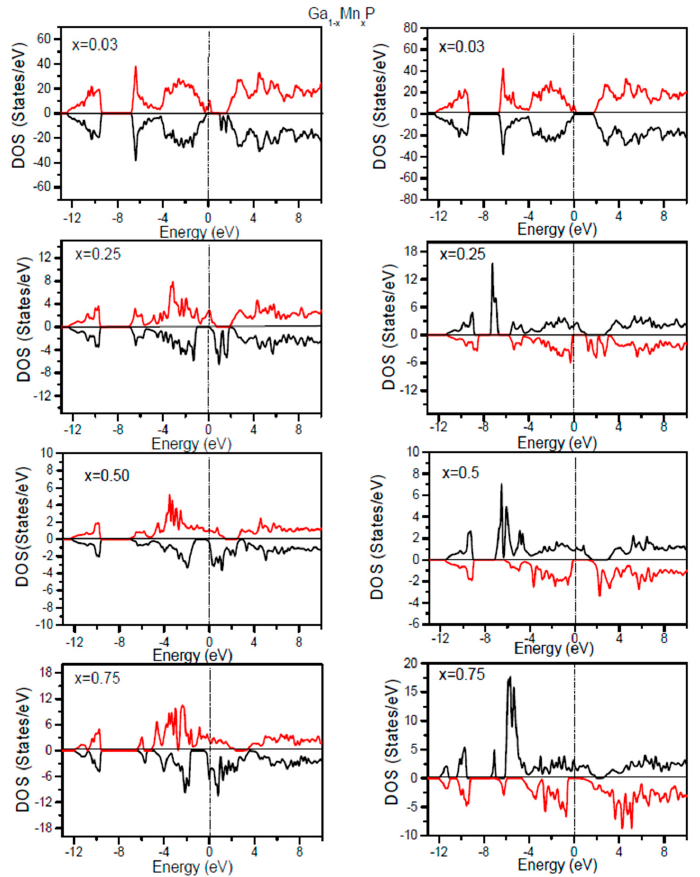
Figure 2. Computed total density of states of Ga 1 − x Mn x P alloys ( x = 0.03, 0.25, 0.5, and 0.75) for spin up and spin down. The vertical dash line denotes the Fermi level. DOS for majority and minority spin channels are illustrated by the +eV and − eV value, respectively. The left panel displays the GGA results and the right panel indicates the GGA + U results.